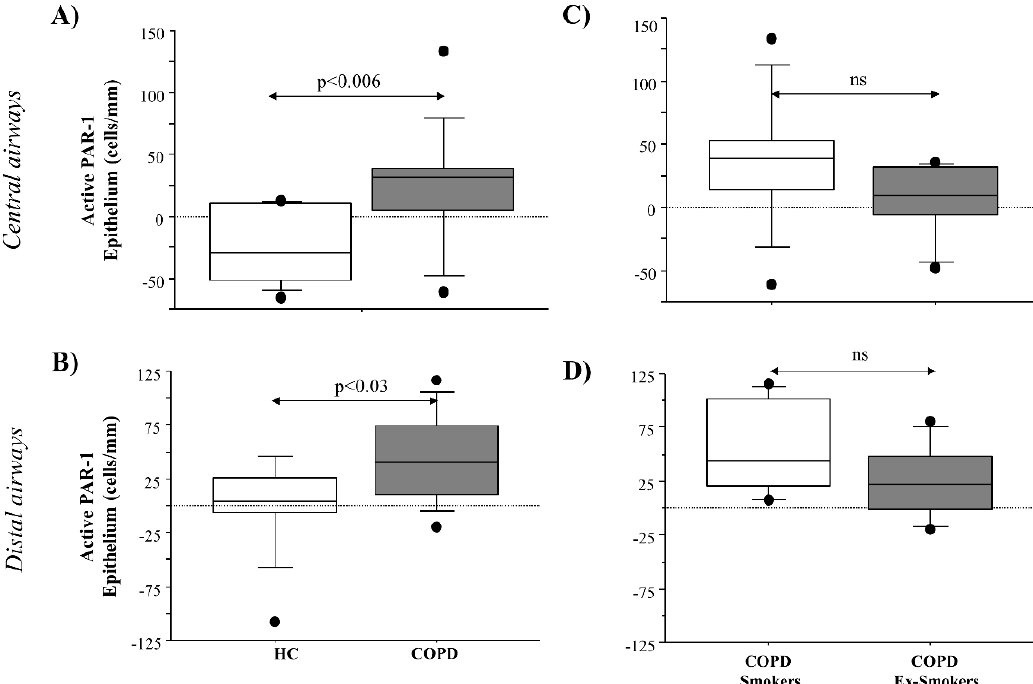
Figure 4. PAR-1 active receptor immunoreactivity in epithelial cells from surgical specimens from HC and COPD patients. PAR-1 active receptor immunoreactivity in epithelial cells of ( A ) central and ( B ) distal airways of COPD patients ( n = 15) and HC subjects ( n = 10), and of ( C ) central and ( D ) distal airways of COPD smokers and ex-smokers.